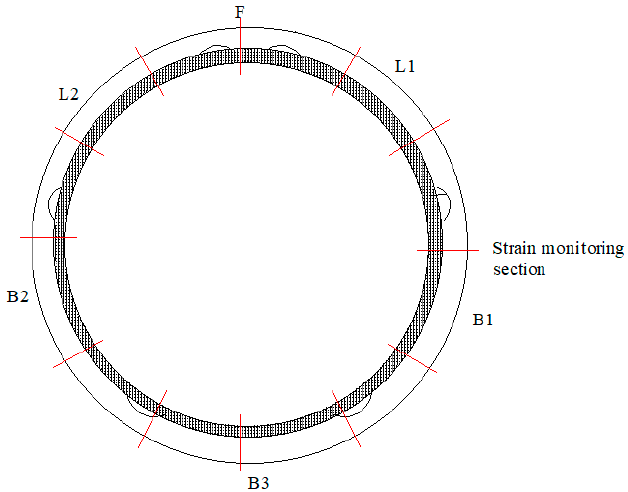
Figure 10. Strain-gauge arrangement scheme.